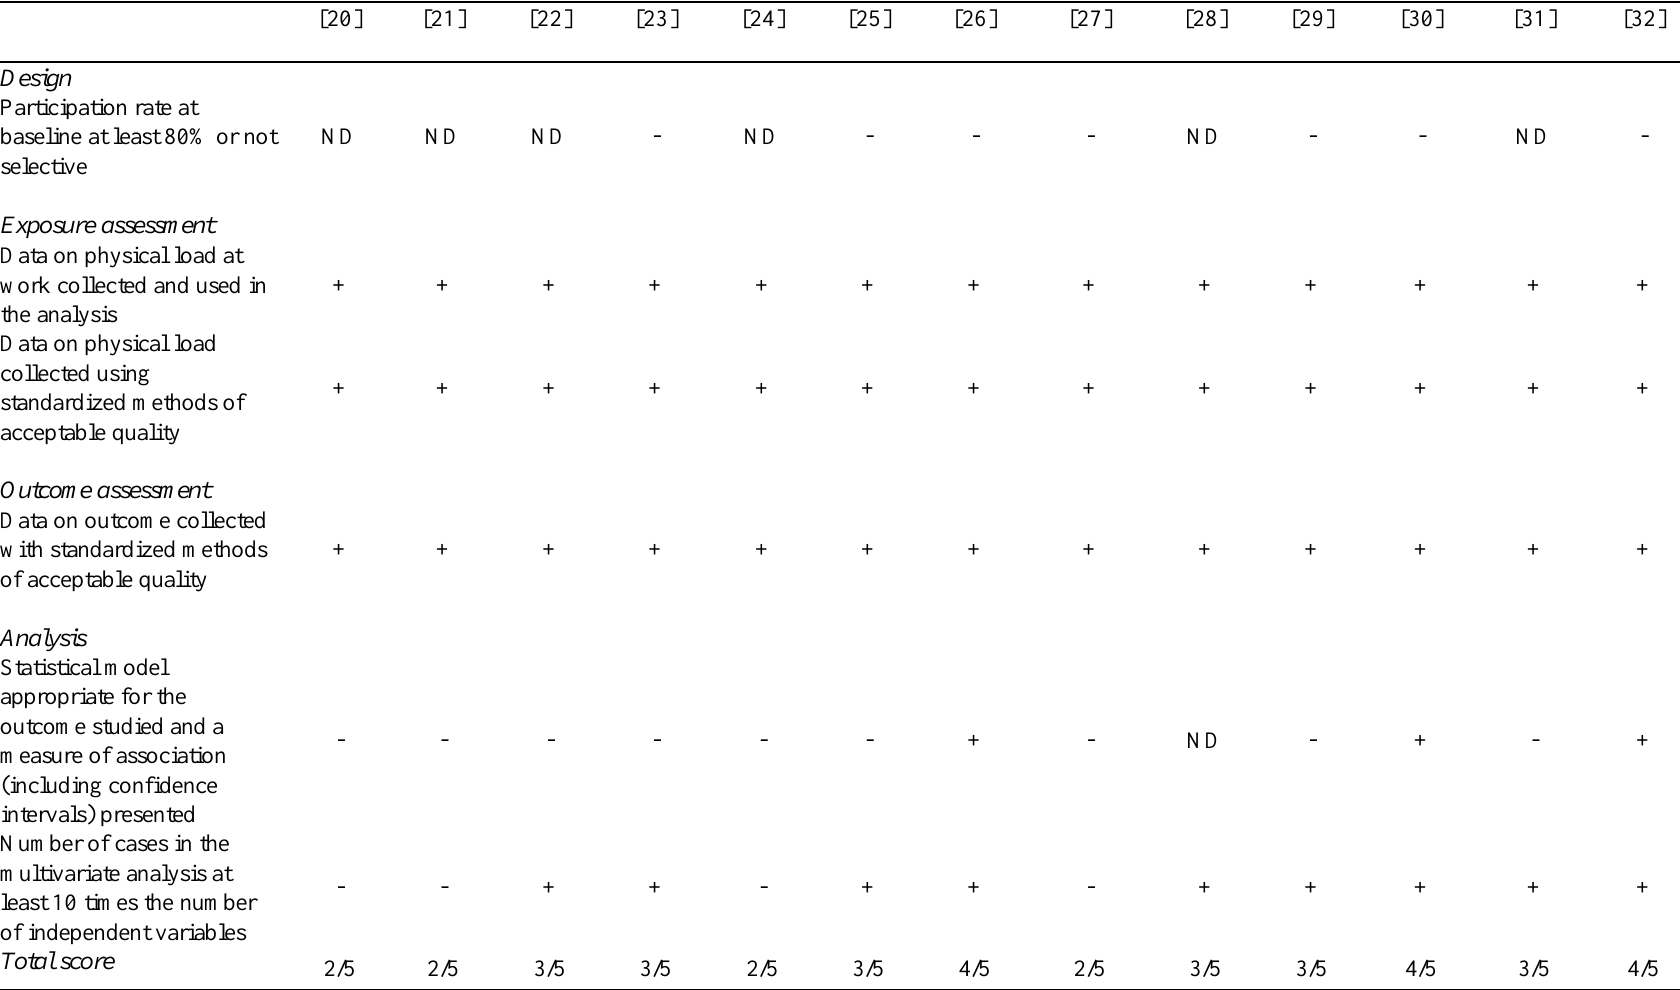
Table 3. Methodological evaluation of the studies included in this review. As mentioned in Method, data on physical load using standardized methods (direct recording) at work was applied as an inclusion criterion for the present study, and not considered for the total score